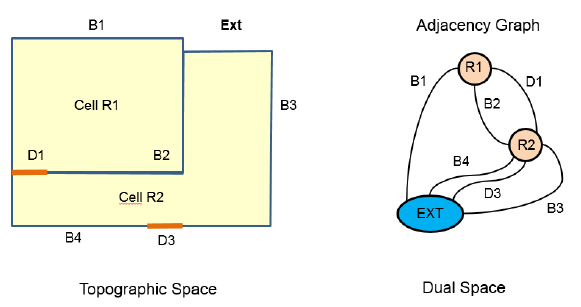
Figure 2. The topographic space and the corresponding